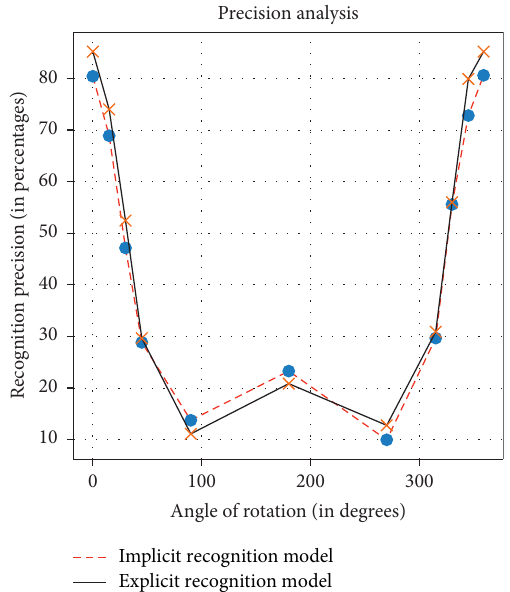
Figure 13: Recognition precision when the testing images rotate 0, 15, 30, 45, 90, 180, 270, 315, 330, 345, and 359 degrees,